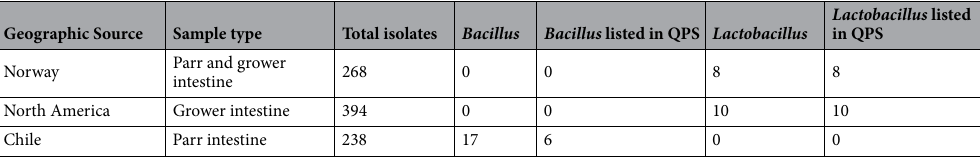
Table 3. Description of probiotic library, Bacillus and Lactobacillus